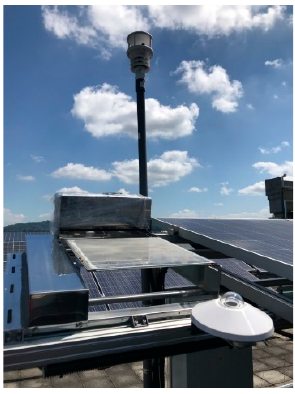
Figure 10. Appearance of the automatic dust measurement platform. Table 7. Simulation result of dust deposition for 3 months with the wind at an inclination angle of 10 ◦ .